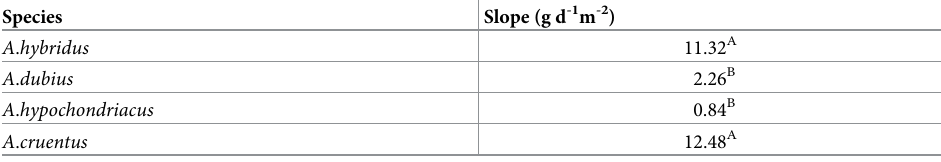
Table 4. The slope of the linear relationship between the natural logarithm of absolute growth rate (AGR) and leaf area per plant.